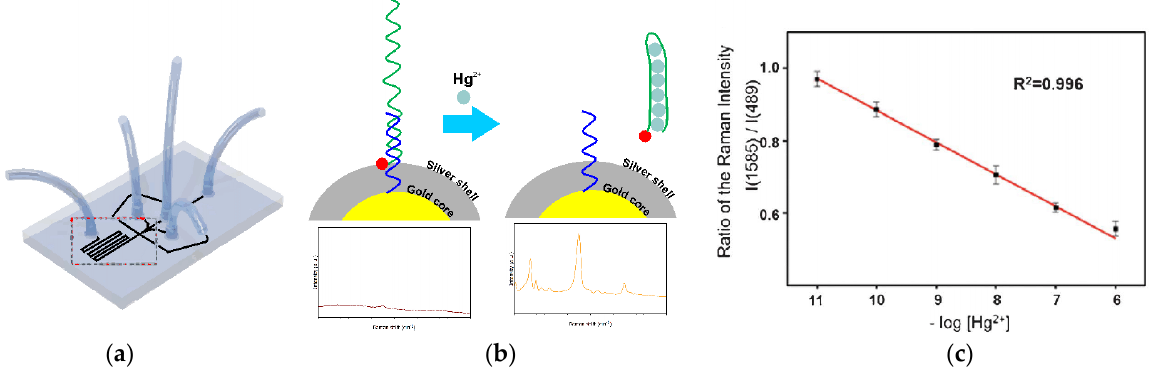
( D ) Figure 31. ( A ) experimental setup; ( B ) Schematic integration of experimental setup; ( C ) and ( D ) ex- emplary result of simultaneous detection of Hg 2+ and Pb 2+ ions in two concentrations, 10 nM and 100 nM respectively [118]. In the case of mercury ions detection, also an attempt was made to show the feasibil- ity of microflow device application in its detection with the use of SERS spectroscopy in a microdroplet channel [119] (Figure 32). In this case, the aptamer-modified Au/Ag core – shell nanoparticles were used as functional sensing probes. All detection processes for the reaction between the mercury(II) ions and aptamer-modified nanoparticles were per-